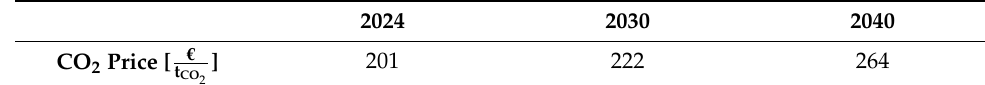
Table 4. Economic costs of carbon